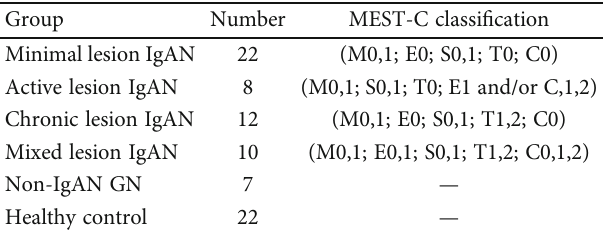
Table 2: The characteristics of samples in the GSE116626